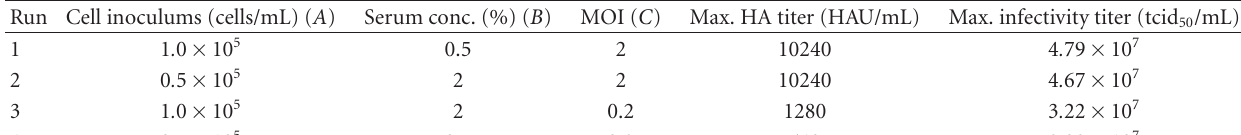
Table 3: NDV Production result (HA and TCID50).